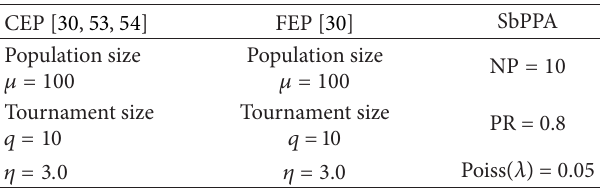
Table 2: Experimental setup used for each algorithm for solving unconstrained global optimization problems 𝑓 11 – 𝑓 26 . All experi- ments are repeated 50